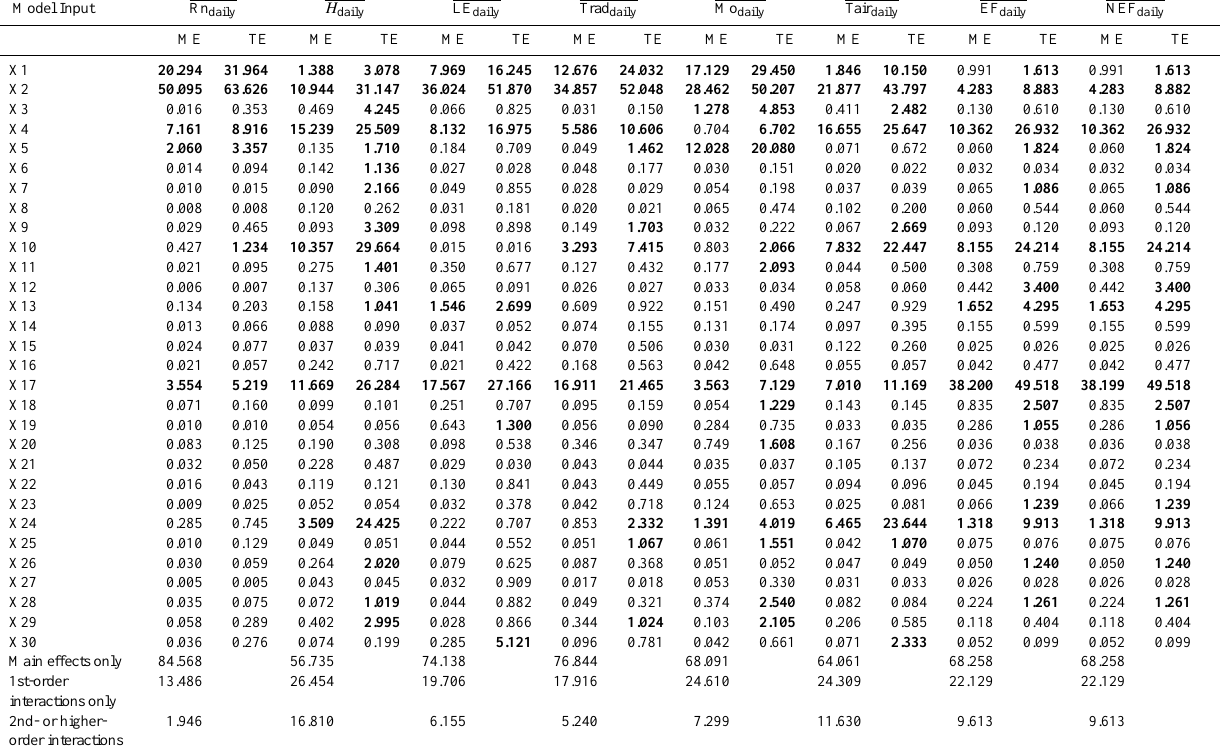
Table 4. Summarised results from the implementation of the BACCO GEM-SA method on the different outputs simulated by SimSphere using the normal PDFs. Computed main (ME) and total effect (TE) indices by the GEM tool (expressed as %) for each of the model parameters are shown, whereas the last three lines summarise the percentages of the explained total output variance of the main effects alone and after including the interaction effects. Input parameters with a variance decomposition of greater than 1% are highlighted in bold